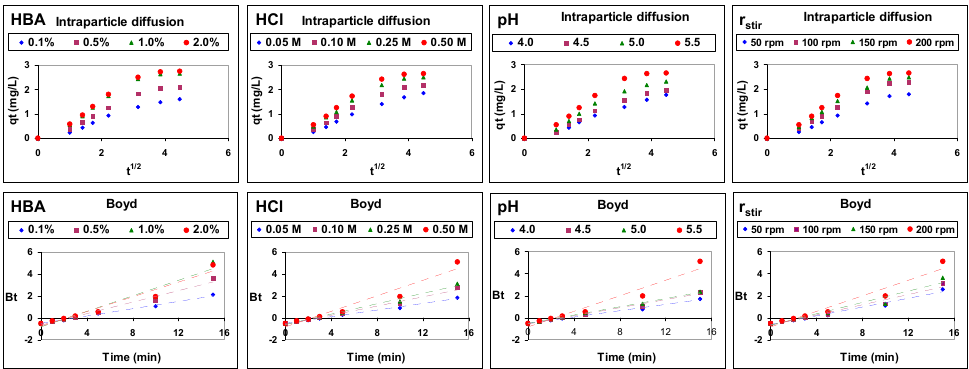
Figure 7. Analysis of the experimental data of carrier ‐ mediated transport of Cu(II) through emulsion liquid membranes by intraparticle diffusion and Boyd models.